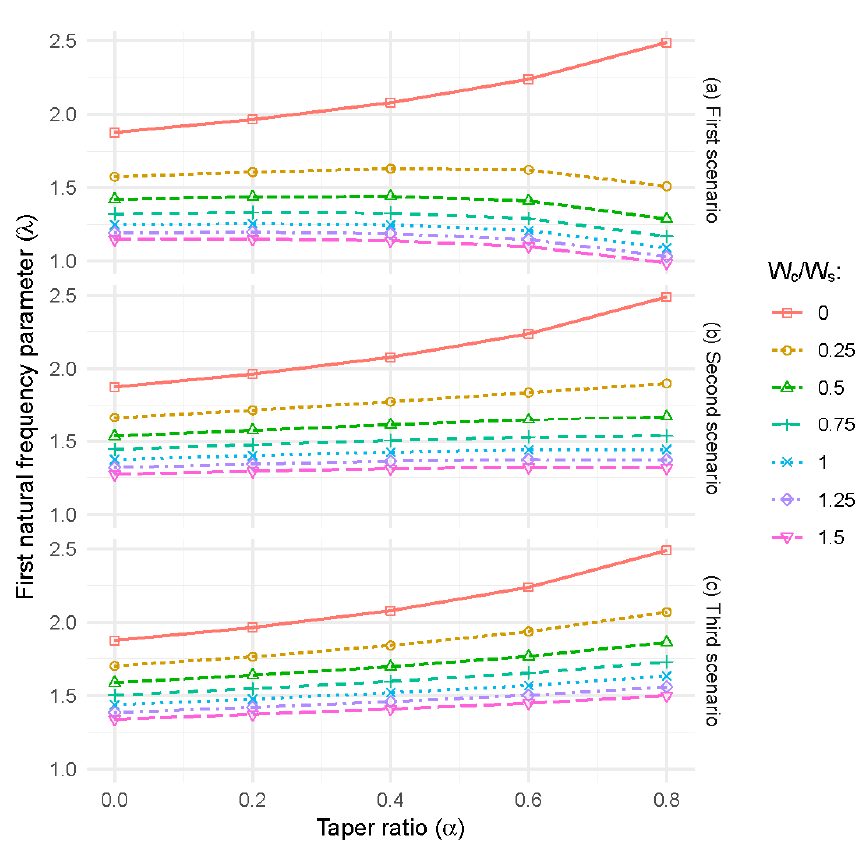
Figure 9. ( a ) Taper ratio versus first natural frequency parameter ratio with crown mass ratio (first scenario; the additional crown mass was applied to the top of the stem), ( b ) taper ratio versus first natural frequency parameter ratio with crown mass ratio (second scenario; the additional crown mass was applied to the upper two-thirds (by volume) of the stem) and ( c ) taper ratio versus first natural frequency parameter ratio with crown mass ratio (third scenario; the additional crown mass was applied to the upper half (by volume) of the stem).